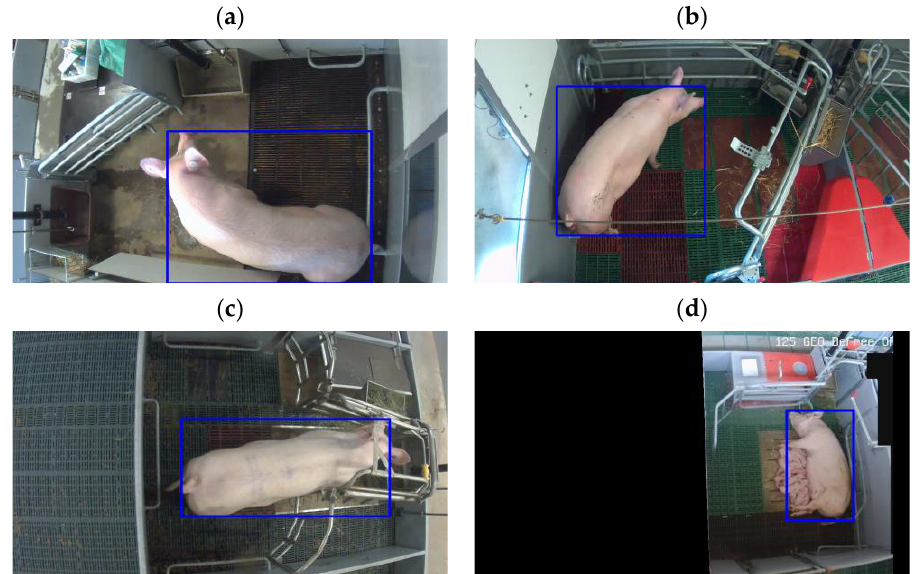
Figure 2. Labeled images with sows: ( a ) SWAP; ( b ) trapezoid; ( c ) wing; ( d ) BeFree (left pen under camera view is masked).